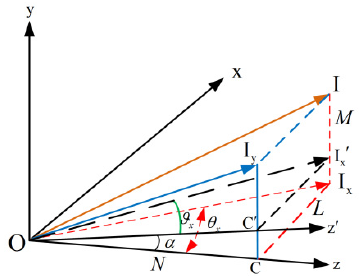
(cid:48) (cid:48) C (cid:48) . I x is parallel to I x C .